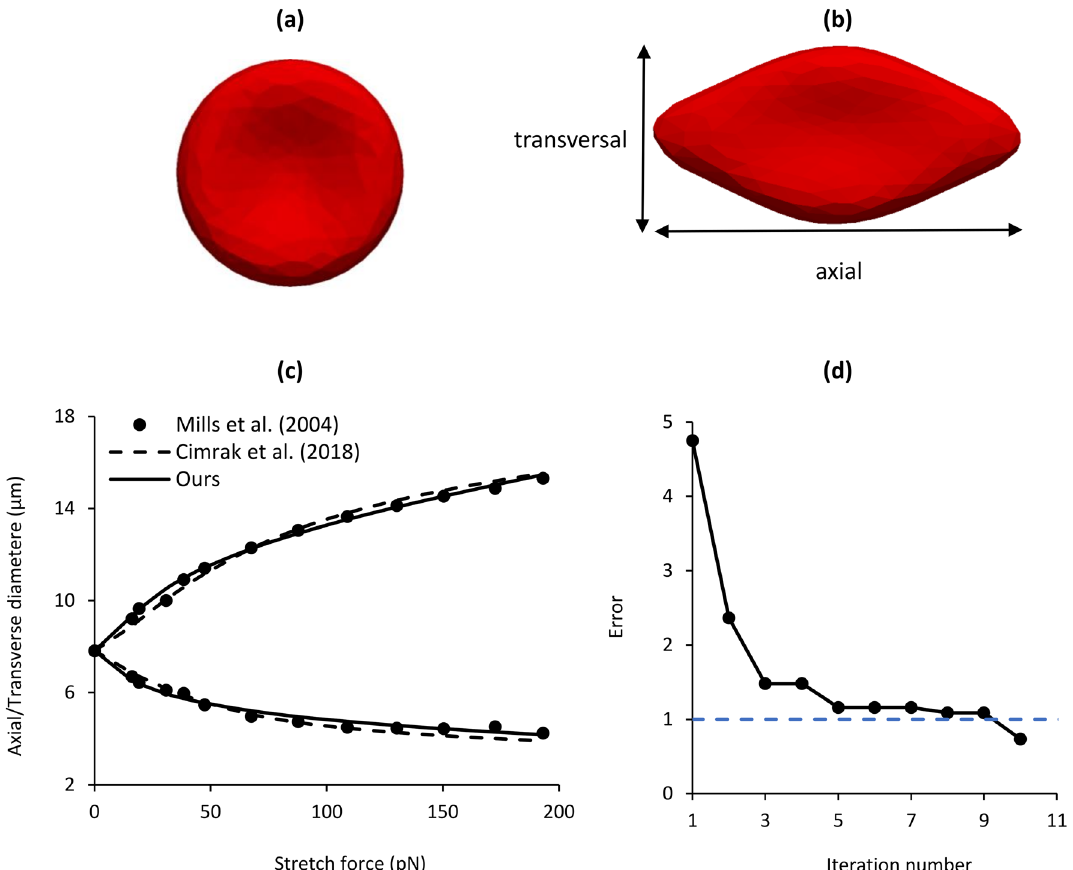
Figure 2. Validation of the proposed parameter identification method using stretch experiments of the red blood cell (RBC) with 374 nodes ( a ) relaxed state, ( b ) stretched state, ( c ) comparison of RBC stretch results obtained (1) experimentally by Mills et al. 3 using optical tweezers, (2) numerically by Cimrak et al. 15 using parameters given in Table 6 and (3) numerically using the parameters identified using the proposed genetic algorithm identification method. The model with parameters identified using the proposed method can replicate experimental data more closely than the model by Cimrak et al. ( d ) error minimization evolution of the proposed method. The main drop in the error occurred in the first five iterations and the five next iterations fine tuned the parameters and decreased the error to less than the threshold of one.